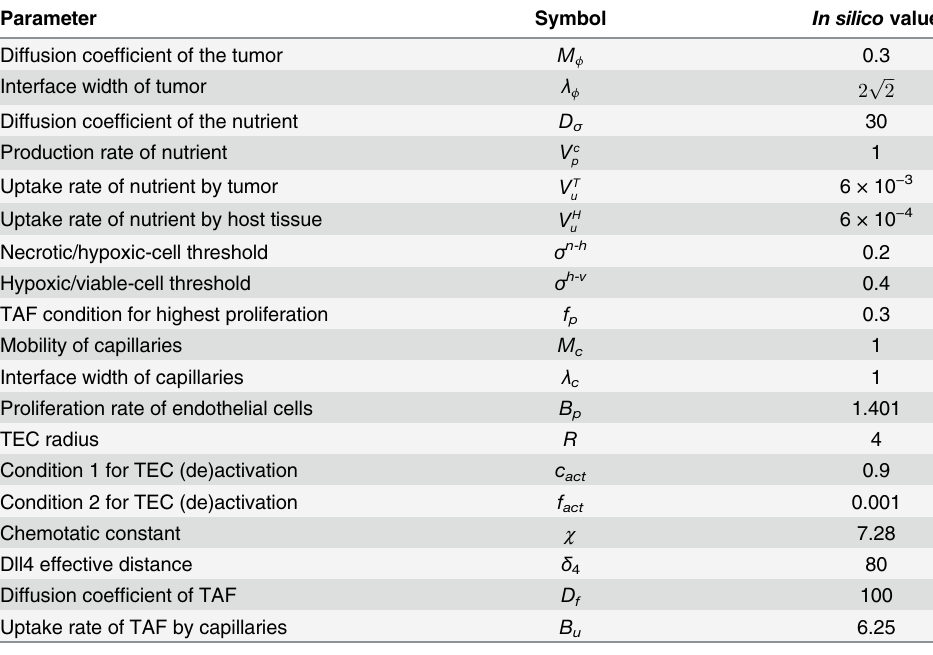
Parameters related to angiogenesis are obtained from